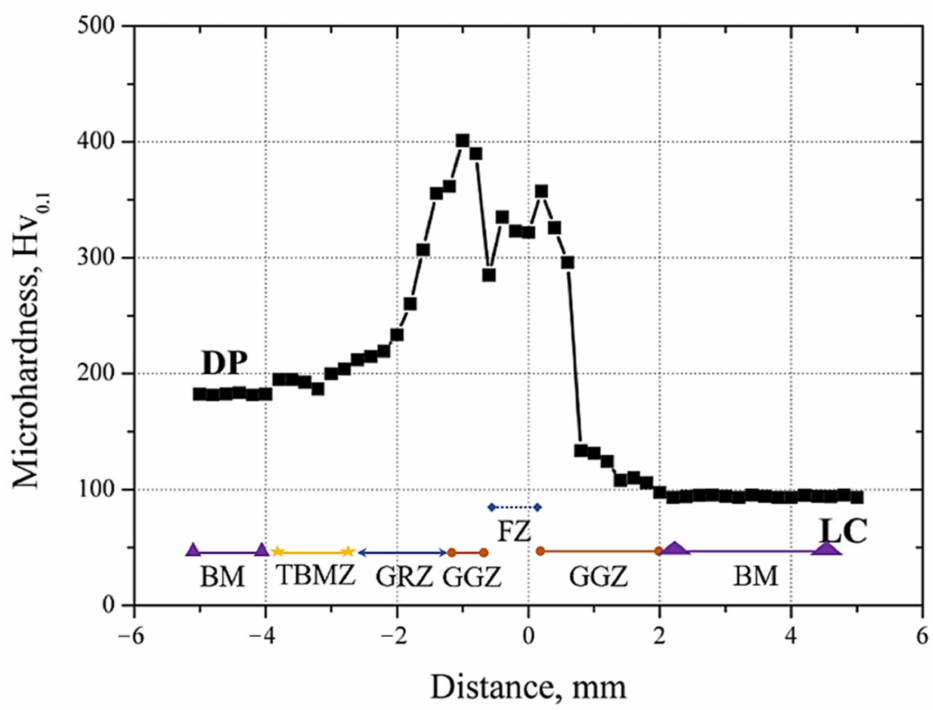
Figure 14. Microhardness profile of dissimilar welding LC–DP steels.